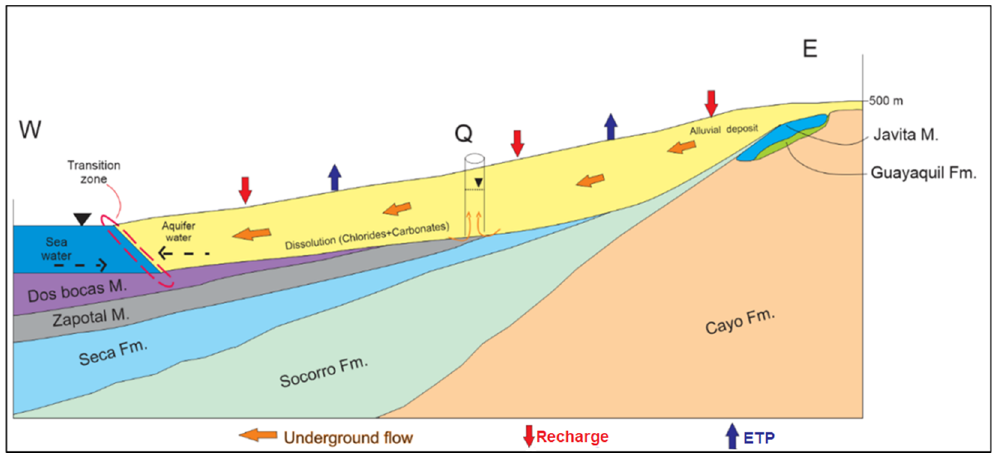
Figure 2. Conceptual model of the hydrogeological system of the Manglaralto river basin [19].